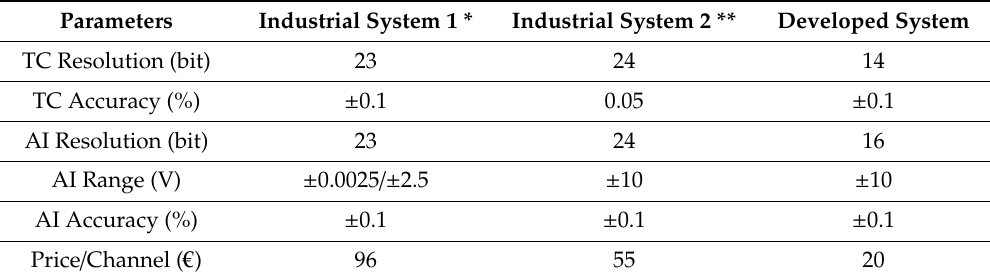
Table 1. Summary of the main features between two industrial standard acquisition systems and the developed hybrid system that mix industrial grade components with custom devices.